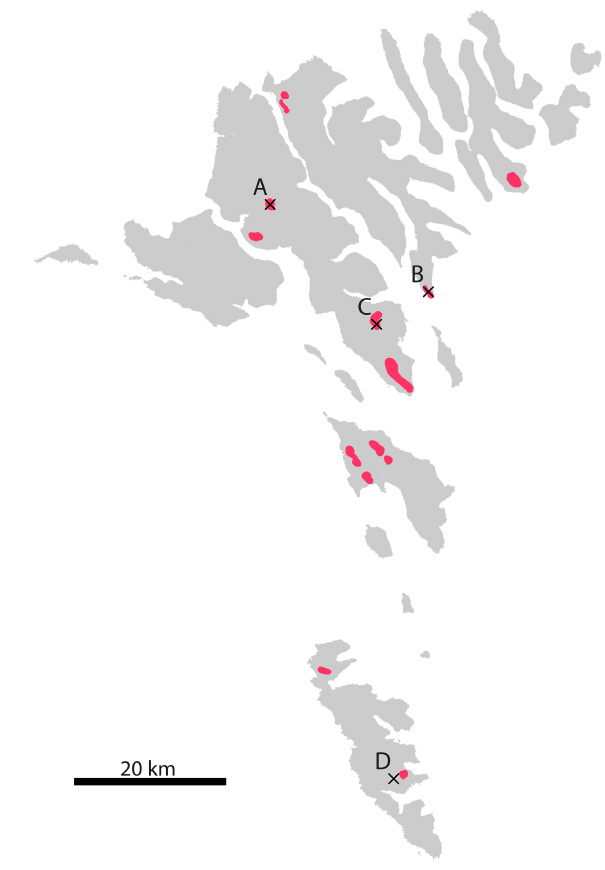
Figure 2. Gray areas mark the terrain of the Faroe Islands. Red patches mark current and potential wind farm locations as se- lected by Magnussen (2017). Black markers pinpoint sites from which actual measured data are available for the period of July 2016 to June 2018, denoted by the letters A to D. The area of the terrain was created using a 10m raster map extracted from https://www.foroyakort.fo/ (last access: 16 October 2022), created in Denmark from satellite data from 2017.